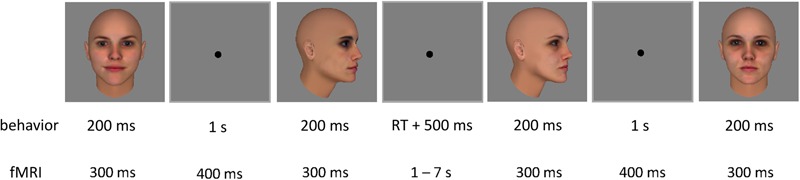
Two example trials of the test phase, with one inter-trial interval. Each trial contained two sequential face images. In the behavioral experiment, each image was presented for 200 ms, with an inter-stimulus interval of 1 s. A fixation cross was shown for 500 ms after participants’ response before the next trial started. In the fMRI adaptation experiment, each image was presented for 300 ms each, with an inter-stimulus interval of 400 ms. The inter-trial interval was jittered between 1 and 7 s.